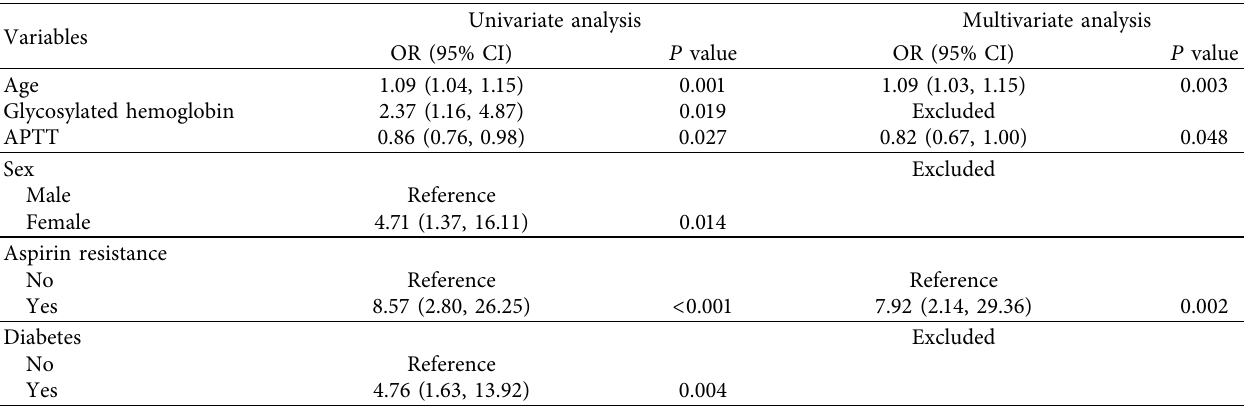
Table 6: Univariate and multivariate logistics regression analyses for CR in Han